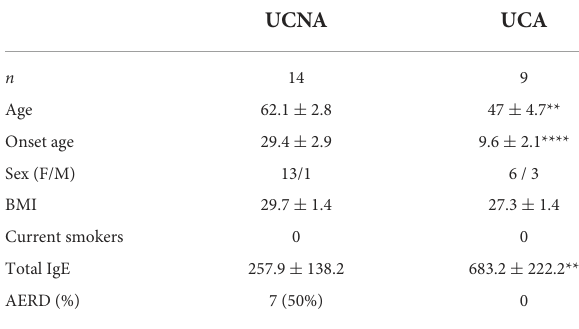
TABLE 1 Clinical characteristics of the recruited